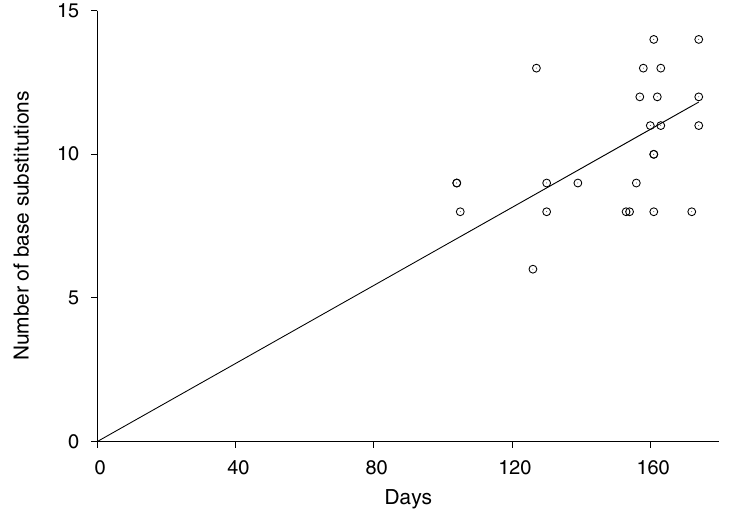
Figure 3. SARS-CoV-2 divergence. Our 25 Los Angeles sequences’ number of base substitutions from the reference sequence Wuhan-Hu-1 (MN908947) was plotted against the collection time of each sequence as days from the reference sequence collection time, December 31st, 2019. The SARS-CoV-2 evolution rate was estimated to be 8.62 × 10 –4 substitutions per site per year (95% confidence interval: 7.96 × 10 –4 to 9.24 × 10 –4 ) by linear regression (solid